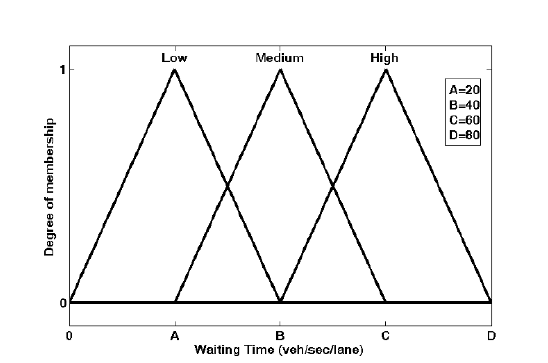
Figure 6. Fuzzy membership functions for AVWT